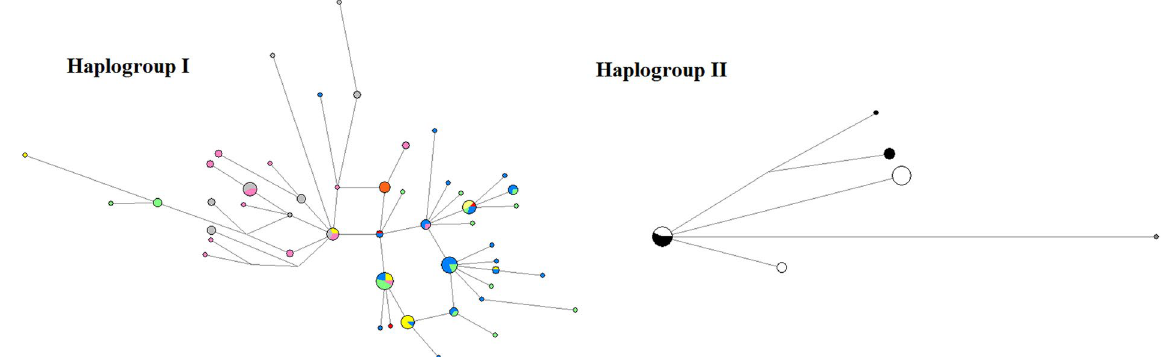
Figure 4. Median joining haplotype network of Haematobia exigua haplogroups in Southeast Asia. Each haplotype is represented by a circle. Relative sizes of the circles indicate haplotype frequency. Circles of the same colour represent haplotypes from the same population (green = North peninsula, blue = East peninsula, red = West peninsula, yellow = South peninsula, pink = Central Thailand, orange = South-Central Cambodia, grey = North Borneo, black = Central Java, and white = West